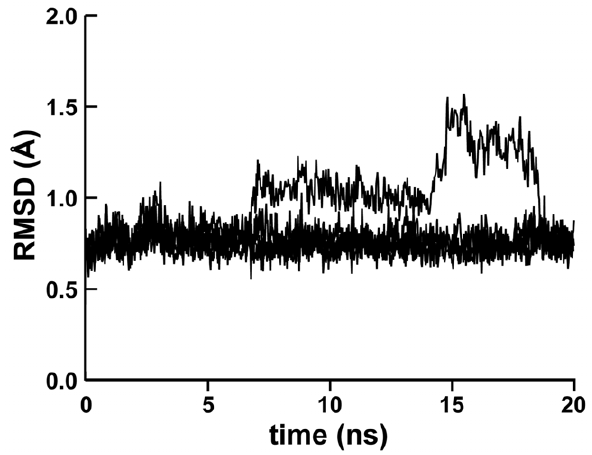
Figure 1. MD equilibration. The five MD trajectories were aligned by protein alpha-carbon atoms, and the RMSD of each trajectory relative